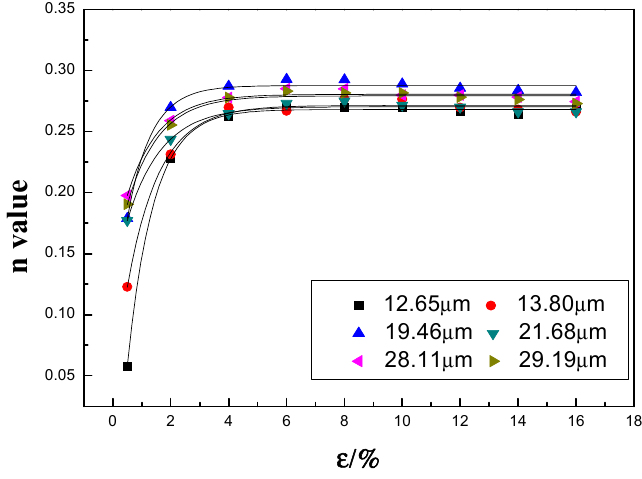
Figure 7. Evolution of n value at different target strains and the fitting results.